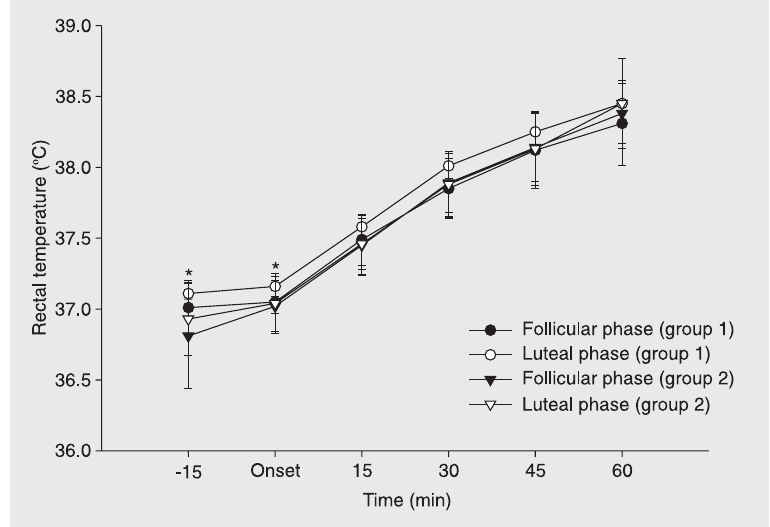
Figure 1. Rectal temperature during the exercise performed in different phases of the menstrual cycle. Group 1 showed serum progesterone and basal temperature elevation in the luteal phase, and group 2 showed no elevations. Data are reported as means ± SD. Rectal temperature was higher during the luteal phase in comparison to the follicular phase in group 1 (*P < 0.05, two-way ANOVA).